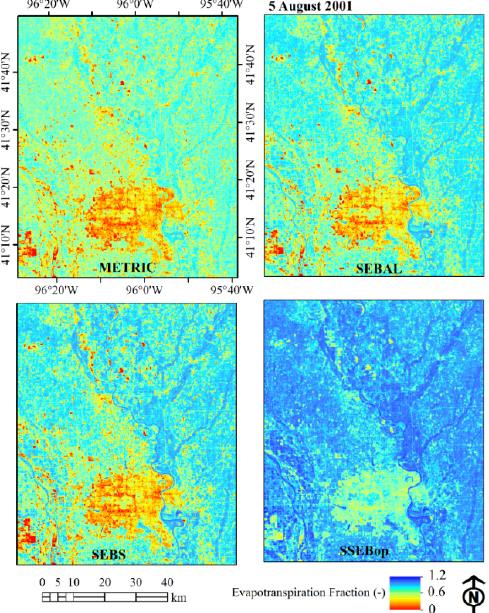
Figure 7. Evaporative fraction map computed using the METRIC, SEBAL, SEBS, and SSEBop models from the Landsat image acquired on 5 August 2001.